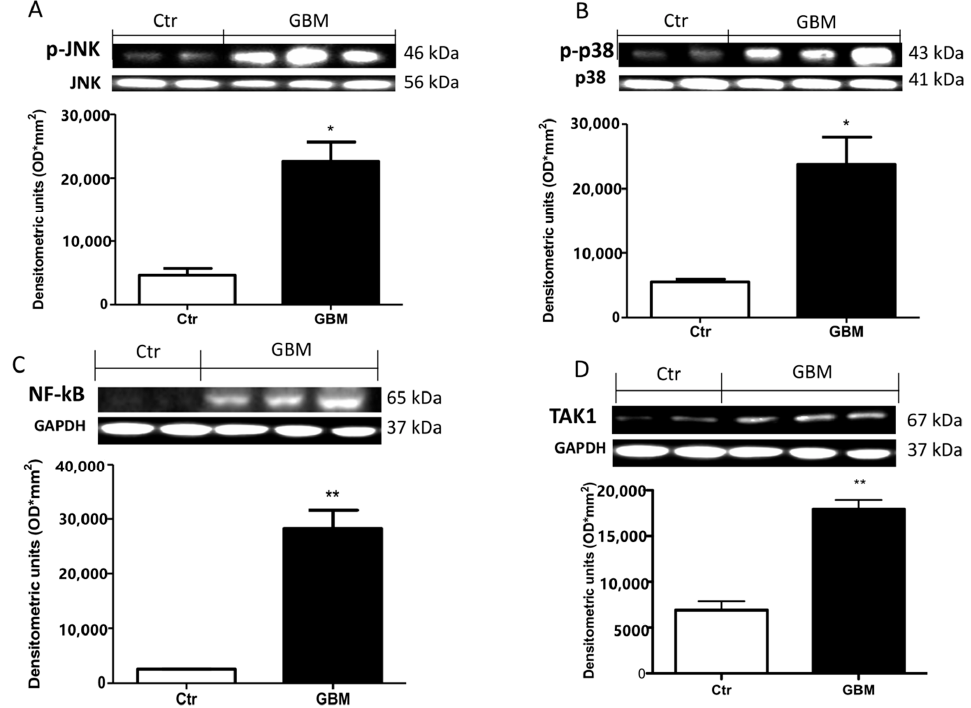
Figure 8. Effect of 5Z-7-ox and TMZ in mitogen-activated protein kinase (MAPK) kinase pathway and NfkB in patients. A substantial increase in p-JNK ( A ) and p-p38 ( B ) expression in glioblastoma patients compared to the control group was observed by Western blot analysis. Panel C shows an increase in NF- κ B traslocation in the GMB patients sample compared to patients in the control group ( C ). Panel ( D ) shows a notable up-regulation of TAk1 in GBM patients. Data are representative of at least three independent experiments. ( A , B ) from the same brain samples * p < 0.05 vs. CTR. ( C , D ) ** p < 0.01 vs. CTR. Original blots are shown in Figures S6.